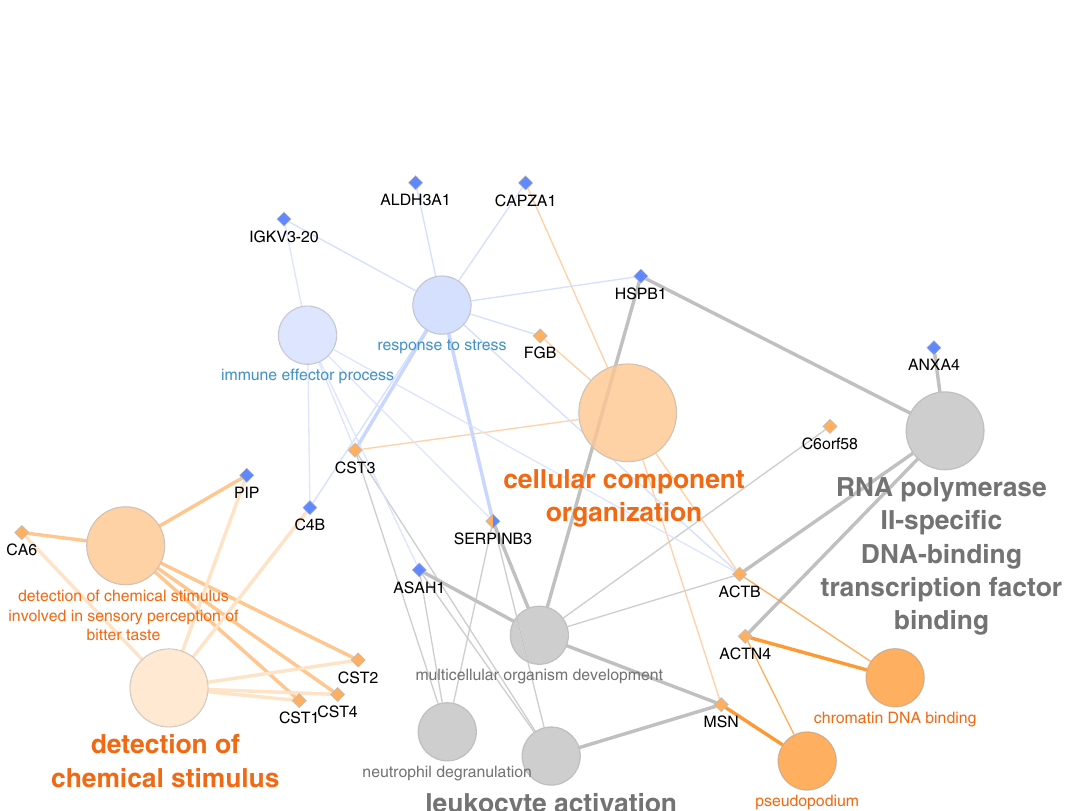
Figure 10. Interactome of GO terms differentially expressed in the saliva of COVID-19 patients depending of disease severity, and their intermediate proteins. This analyses have been done with the Cytoscape application ClueGO and the REVIGO tool for GO terms selection. GO terms and proteins related to mild COVID-19 are in blue, and those related to severe COVID-19 are in orange. GO terms in grey could not be attributed specifically to any disease severity. Source: ClueGO (v2.5.8) app for Cytoscape